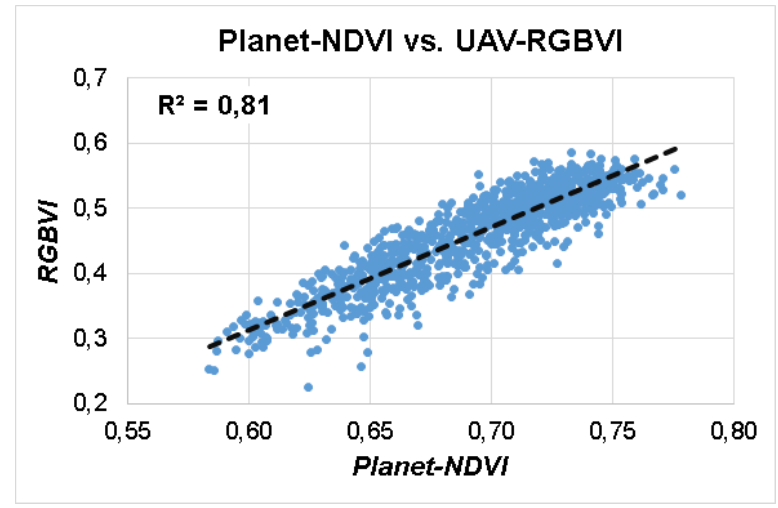
Figure 7 . Planet NDVI vs. UAV RGBVI for the 10 m polygon grid (n =